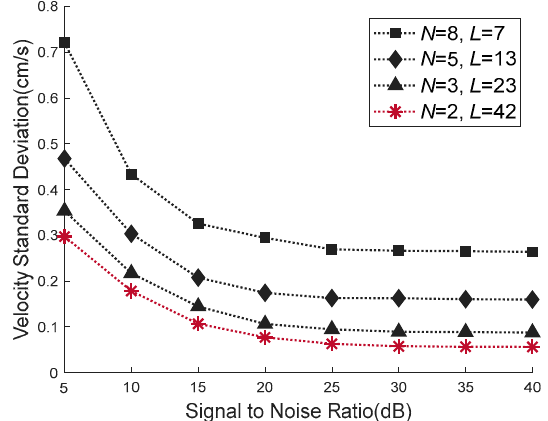
Figure 9. Comparison of the velocity standard deviation between four waveforms. The waveform ( N = 2, L = 42) obtained by the proposed VEAP method achieves the smallest velocity standard deviation.